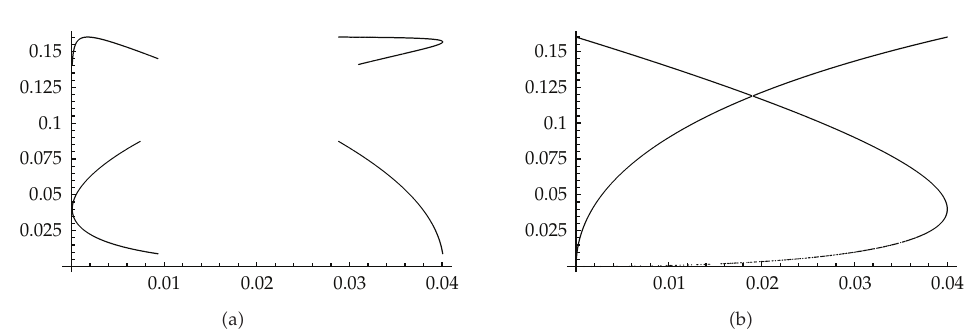
Figure 8: Limit sets for the parameter values 6 . 24 (cid:4) a (cid:5) and 6 . 25 (cid:4) b (cid:5) . They can be observed although they are not properly an attractor of the system.